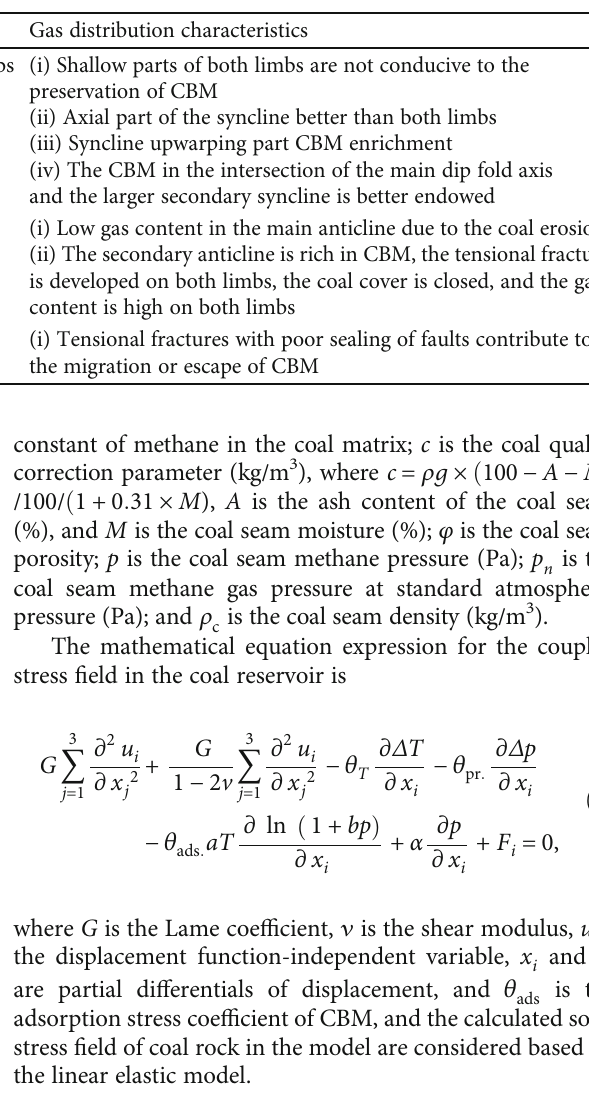
Table 2: Basic types of structures controlling gas content in the Guojiahe well fi